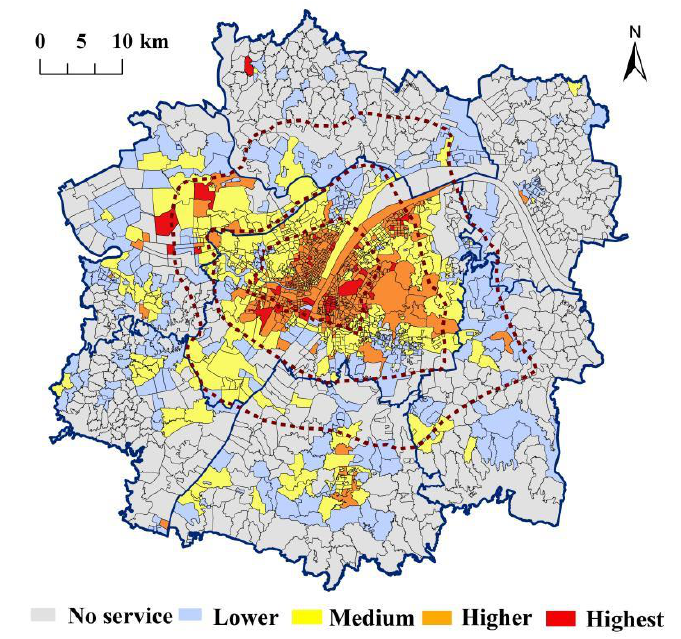
Figure 5. Spatial distribution map of the supply service level enjoyed by community residents.